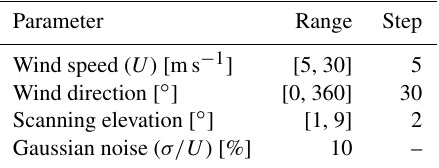
Table A2. Parameter set-up for the VAD